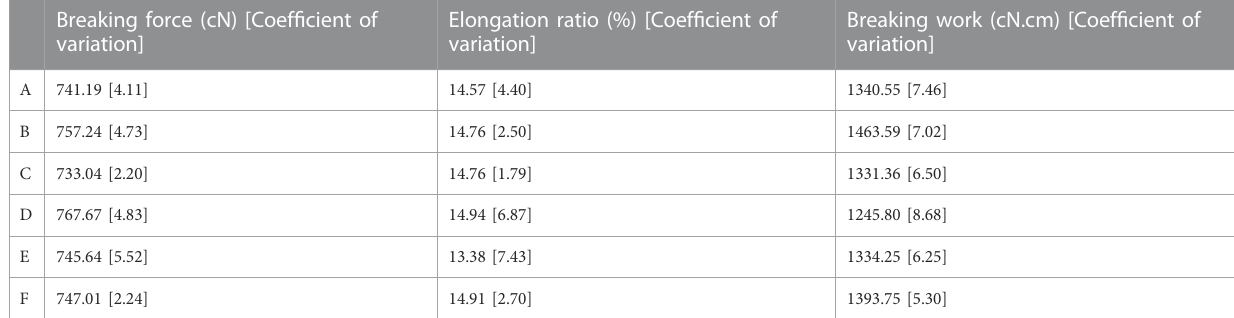
TABLE 4 Tensile property of different composite